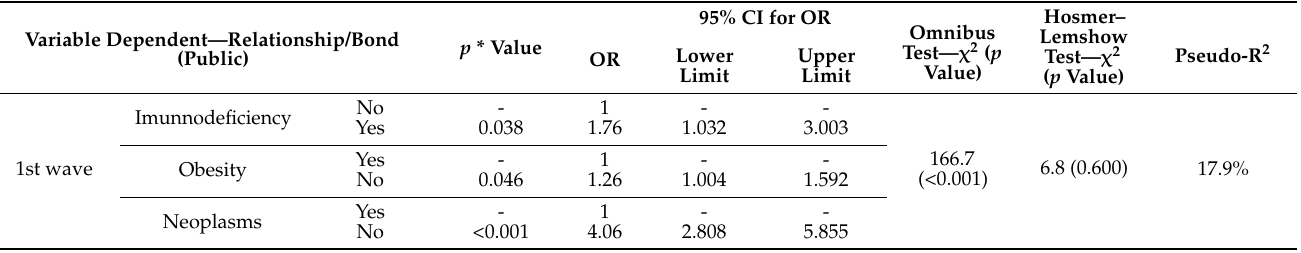
Table 2. Association of the public bond with the socio-clinical variables for the first wave of death incidence. From April 2020 to August 2021, Esp í rito Santo, Brazil.